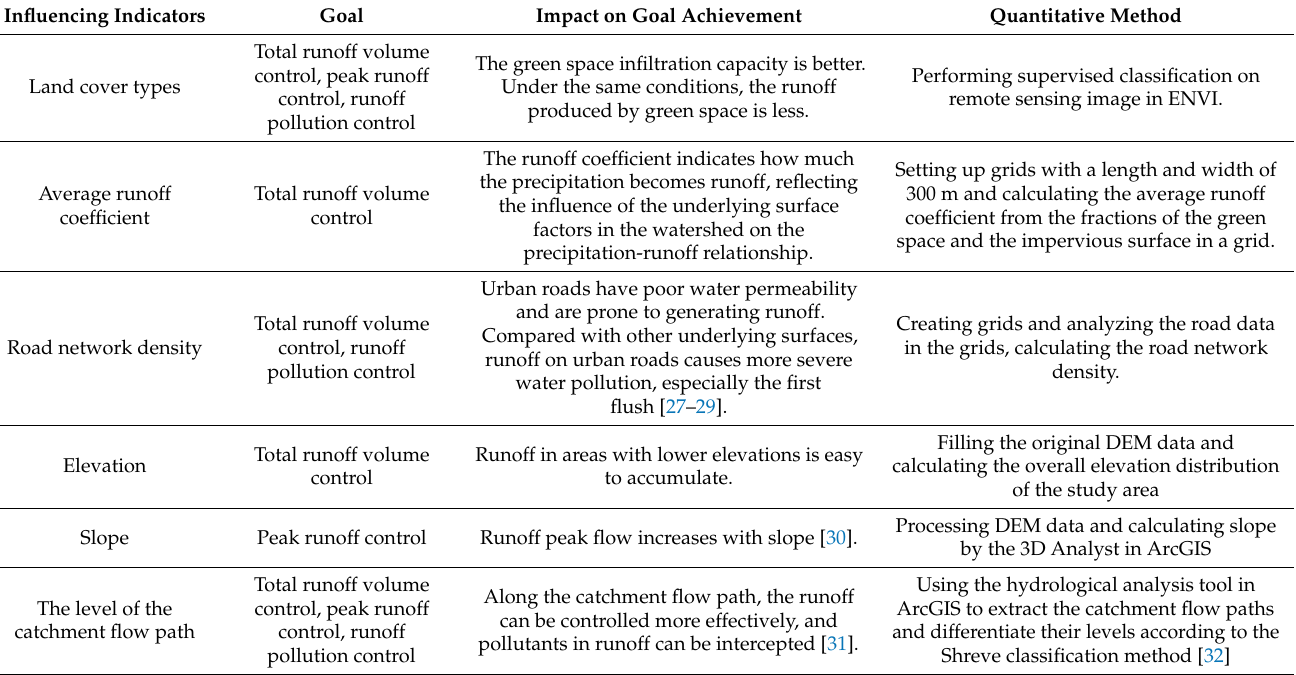
Table 2. Influencing indicators and their quantification methods for the location decision of multi- functional rainwater storage